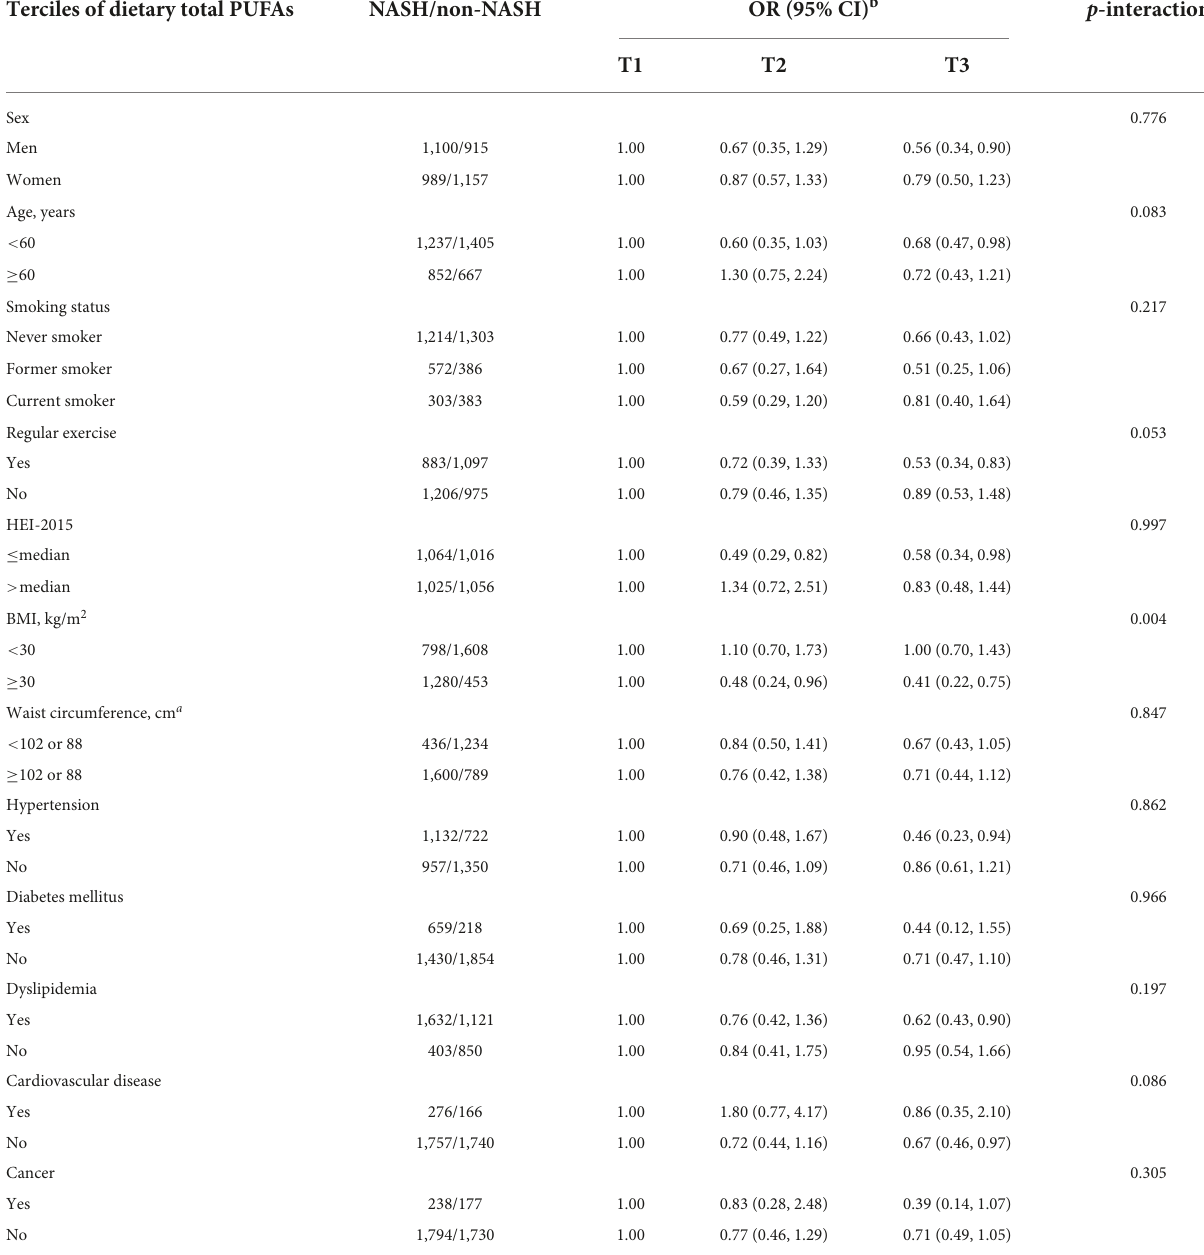
TABLE 4 Odds ratios (ORs) and 95% confidence intervals (CIs) of non-alcoholic steatohepatitis by terciles of dietary total polyunsaturated fatty acids among controls stratified by covariates. Terciles of dietary total PUFAs NASH/non-NASH OR (95% CI) b p